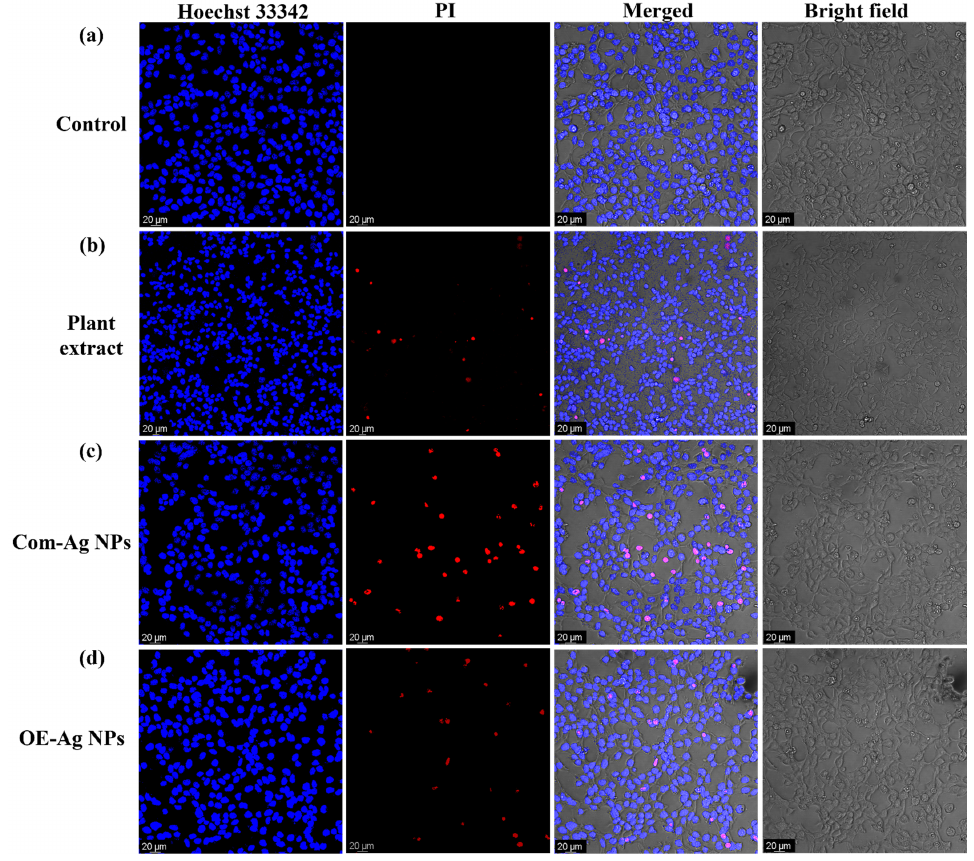
Figure 9. CLSM images of live/dead 293T cells. ( a ) Control (untreated) and treated with ( b ) plant extract, ( c ) Com-Ag NPs, and (d) OE-Ag NPs.